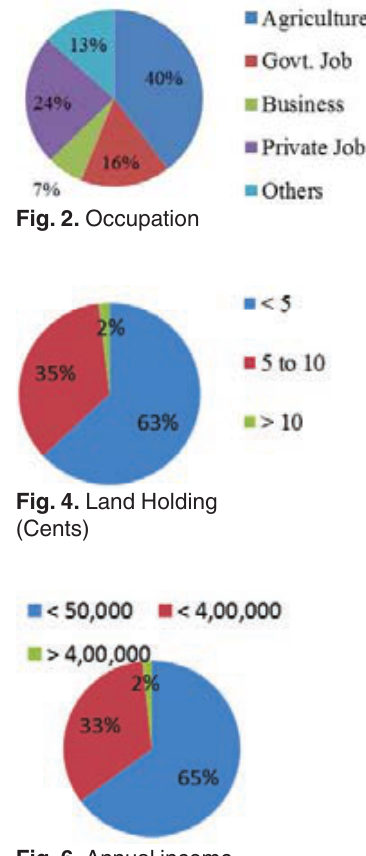
Fig. 5. Milk produced Fig. 6. Annual income